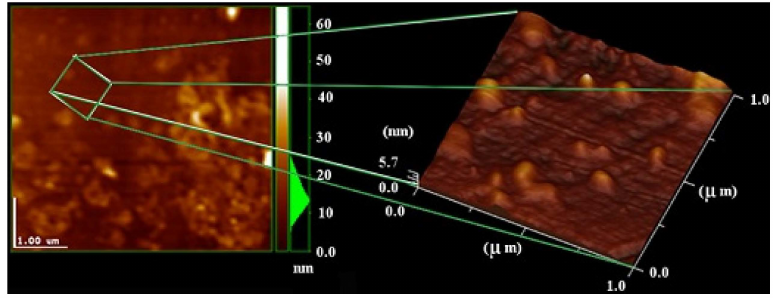
Figure 12. AFM micrographs of 4b monolayer film: frontal and 3D views, respectively.